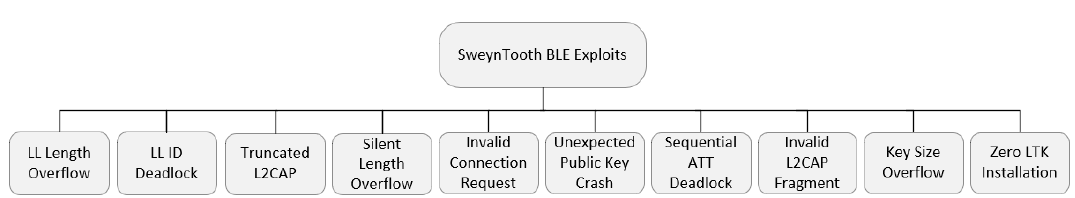
Figure 7. SweynTooth BLE